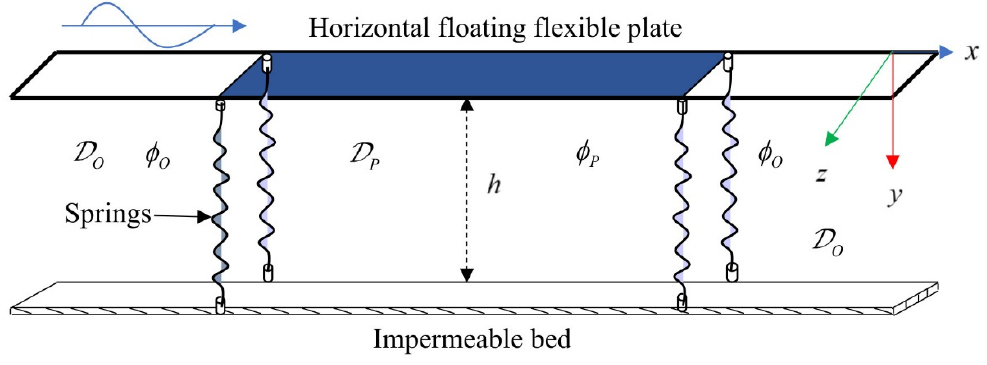
Figure 1. Geometrical representation of the model.